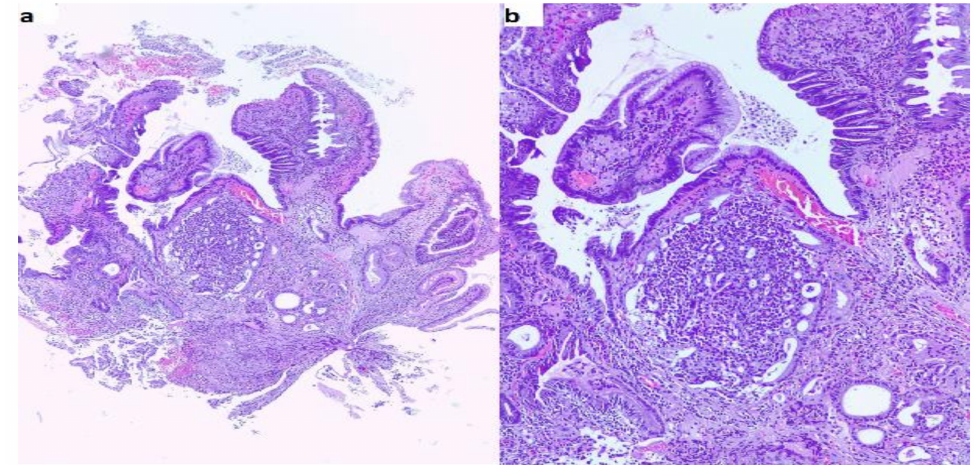
Figure 7. Histological findings. ( a ) HE, 40X. Duodenal biopsy with glandular and cribriform structures in the lamina propria, with the infiltrative aspect. ( b ) HE, 100X. Detail of the previous picture with cribriform structures and focal foveolar metaplasia of the villous epithelia.